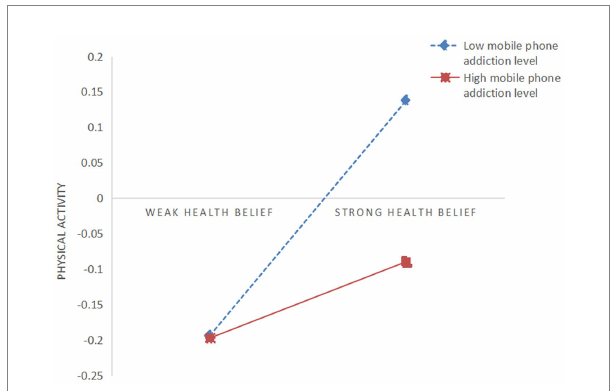
FIGURE 4 The mediating effect of mobile phone addiction on the relationship between health belief and physical activity.